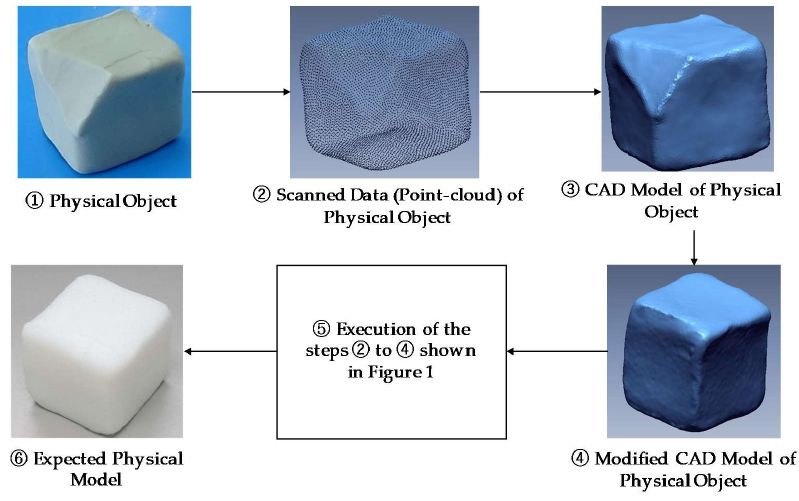
Figure 2. A workflow for Reverse Engineering (RE) based AM.